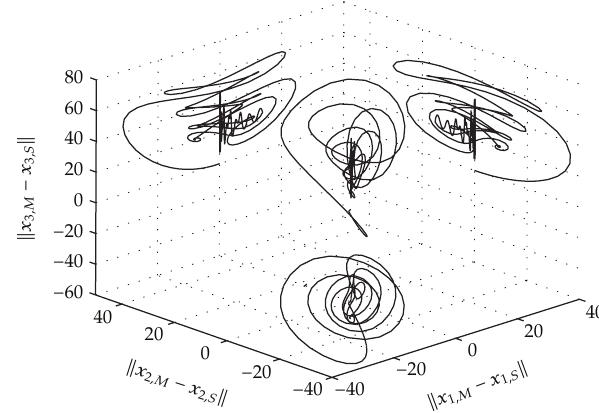
Figure 5: Stabilization of the synchronization error trajectory and its canonical